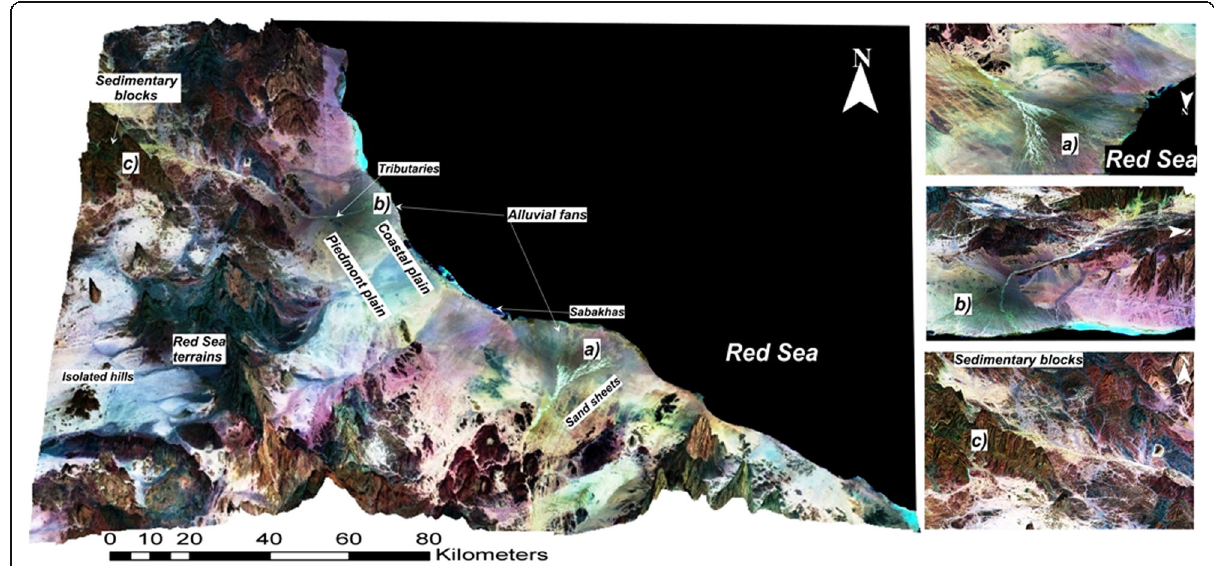
Fig. 2 Three-dimensional (3D) map showing the main landforms units of the study area (SRTM-1 overlaid by LANDSAT8). a and b are showing two of the typical alluvial fans existing in the study area. c is showing the sedimentary blocks which consists of Nubian